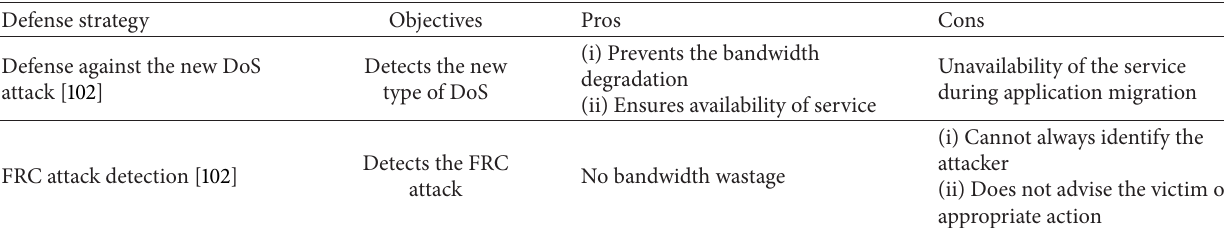
Table 6: DoS attack